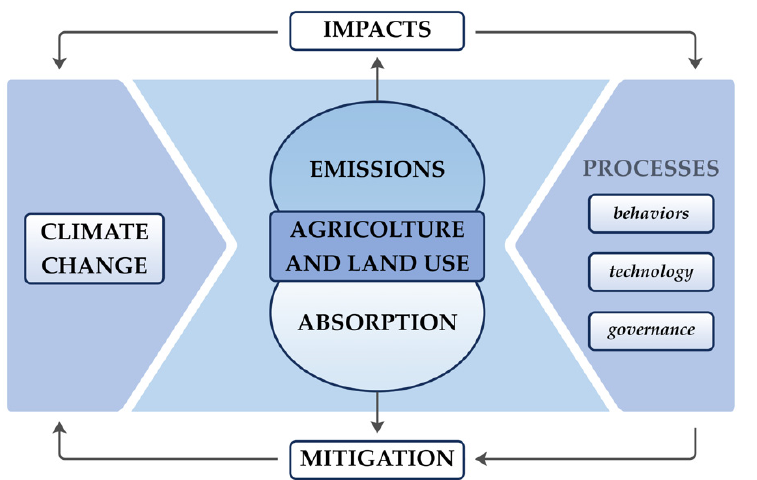
Figure 2. Methodology for assessing the GHG balance. From this figure it can be deduced that agriculture and more generally land use are sources of both CO 2 emission and absorption. Where there is absorption, mitigation occurs, while where there is emission, there is an impact that can be mitigated through specific processes.